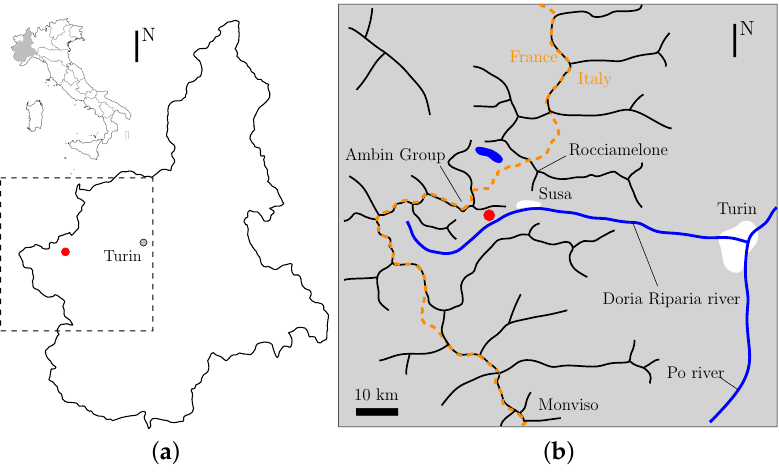
Figure 1. Cels-Morlière study case (red dot in the two maps above): ( a ) Location of the site within the Italian peninsula and the Piedmont region; ( b ) geographical overview of the site within the North-Western Italian Alps.